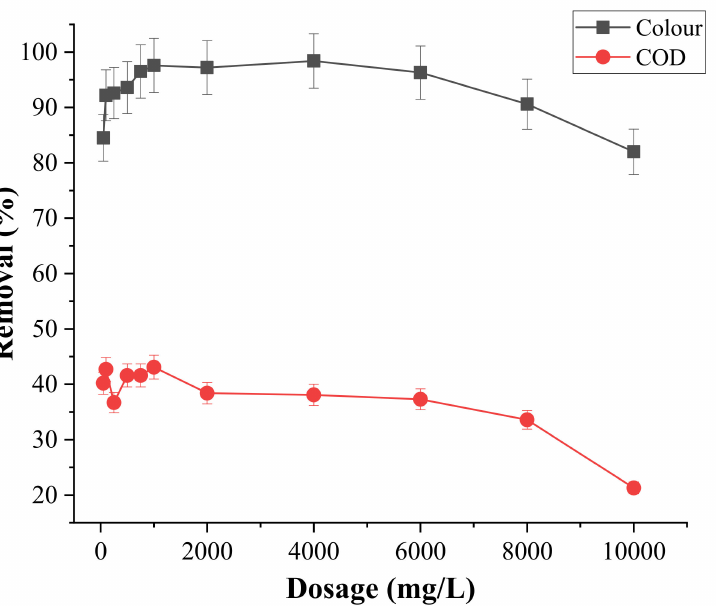
Figure 5. Colour and COD reductions at pH 8 and 8000 mg/L SnCl 4 in the presence of RS as the coagulant